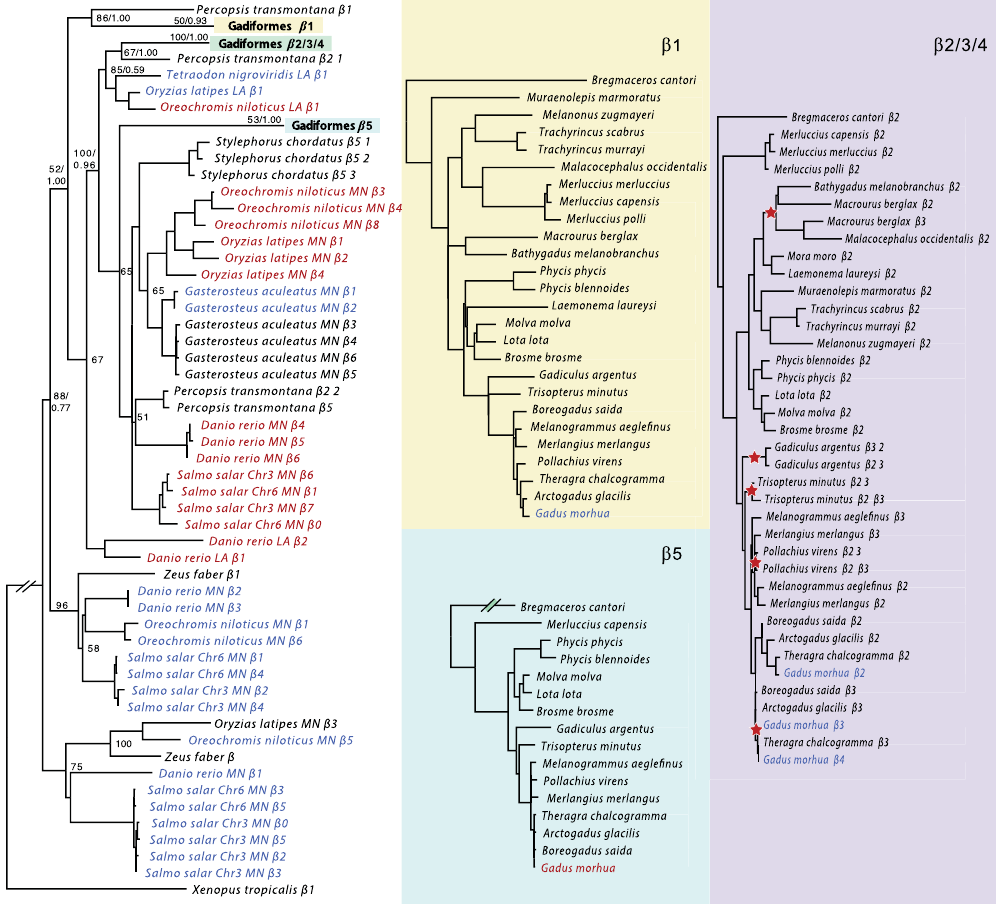
Figure 3. Phylogenetic relationships among β -globin genes. ML phylogeny of β -globin genes from 36 species of teleosts, and western clawed frog ( Xenopus tropicalis ) as the outgroup species. Numbers on nodes show bootstrap values and Bayesian posterior probabilities where topology is concordant, -- denotes support lower than 50/0.50. Sequences are colored according to timing of expression 11, 45 ; embryonic (red), adult (blue) and unknown (black). For each gadiform β -globin gene the phylogenetic tree is shown separately. Lineage specific duplications of β 2 are indicated by red stars. Some branches are shortened for convenience, indicated by